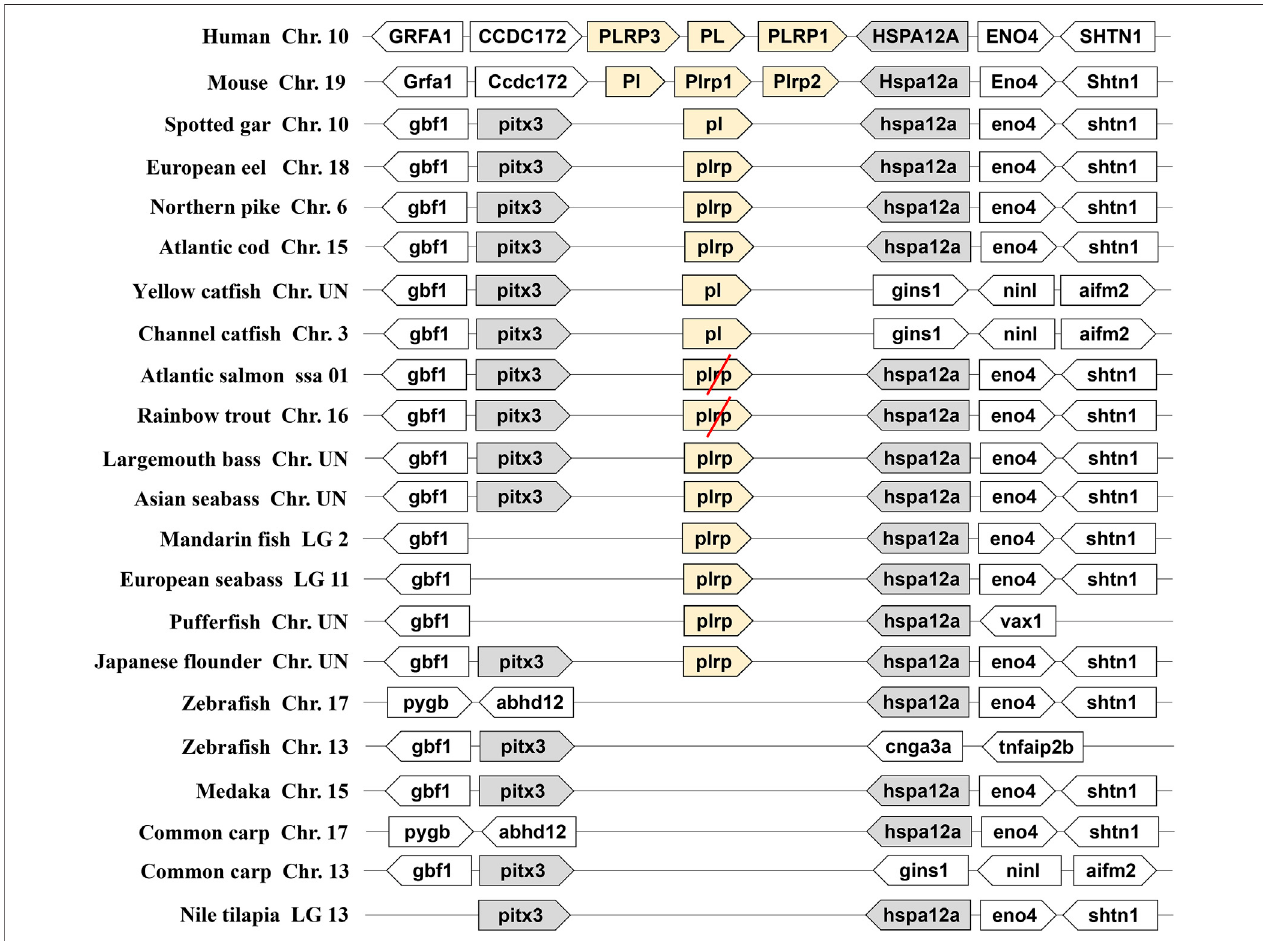
FIGURE 1 | Synteny of pancreatic lipase genes (light yellow) in mammals and fi shes. The conserved neighborhood genes ( pitx3 and hspa12a ) were marked with gray. The pseudogenes were marked with a red slash.